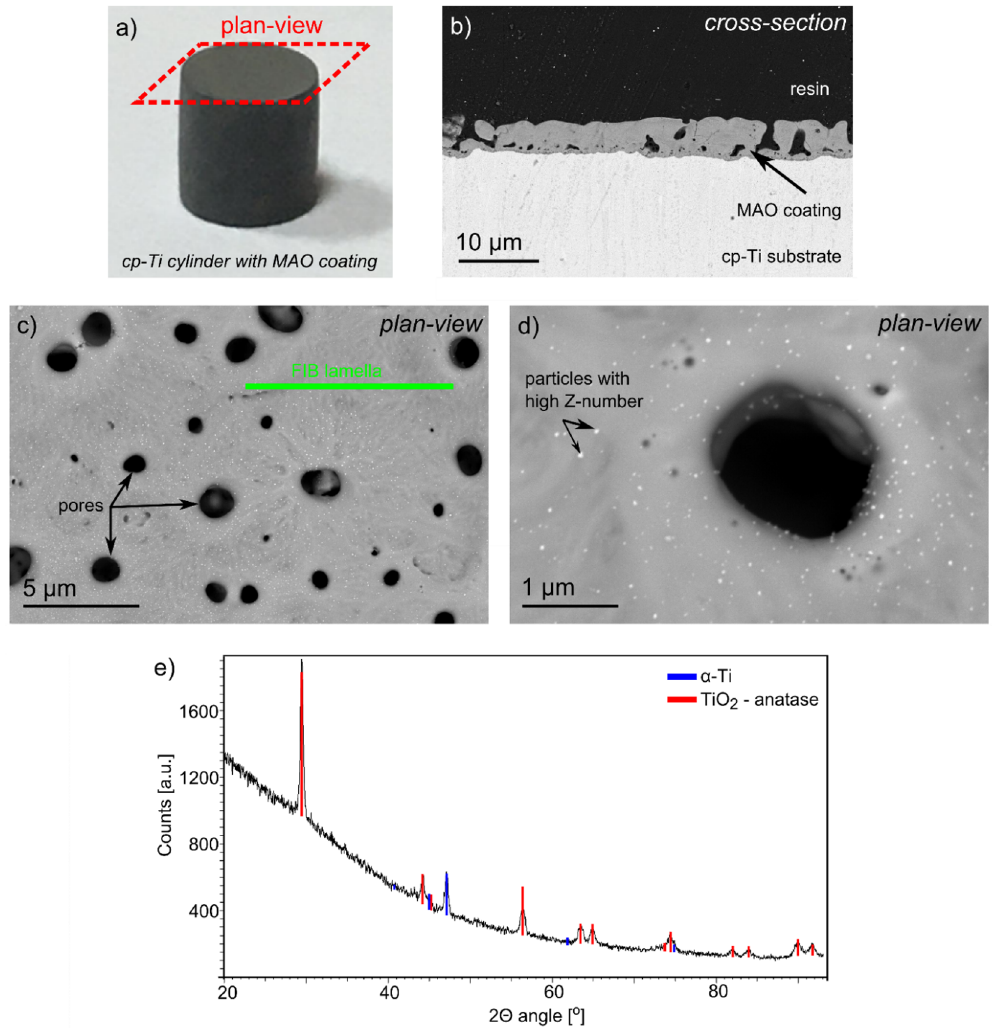
Figure 1. Macroscale photo of the cp-Ti sample with MAO coating ( a ), cross-section SEM/BSE image ( b ), plan-view SEM/BSE image of MAO coatings with the addition of Ag ( c , d ) and GI - XRD pattern recorded from the top surface of the MAO coating ( e